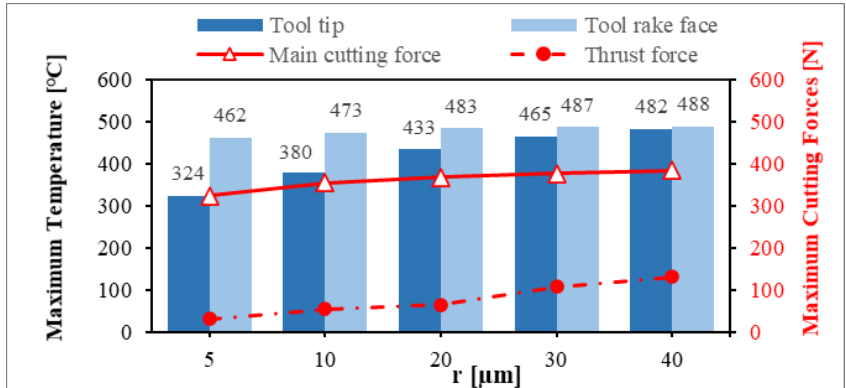
Figure 6. Relationship between the edge radius, forces, and maximum